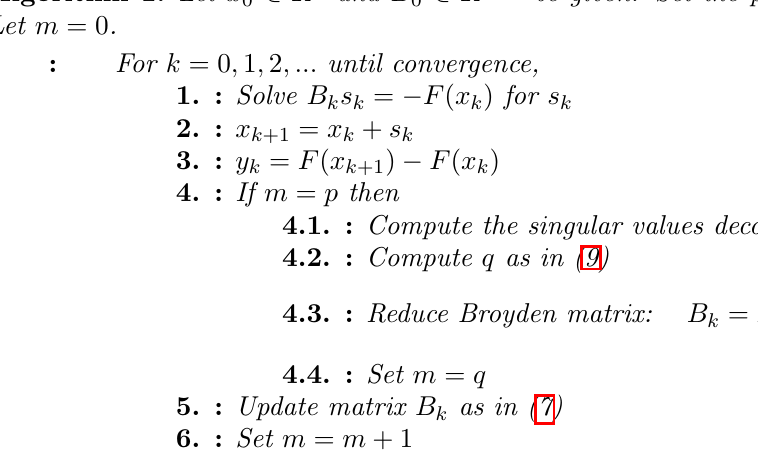
R n and B R n × n be given. Set the parameter p and the accuracy ε > 0 . 0 ∈ 0 ∈